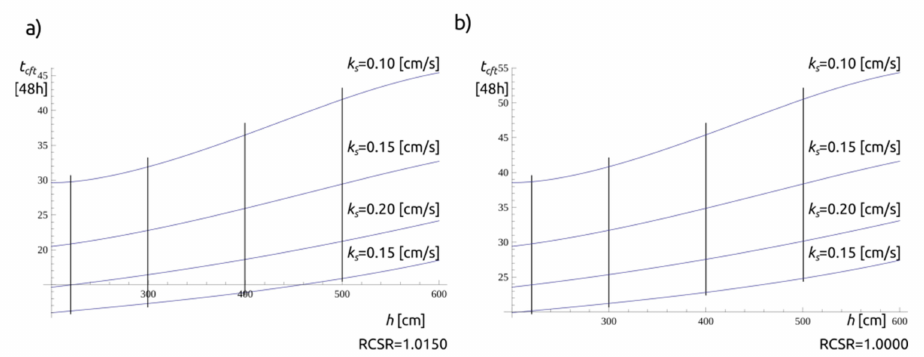
Figure 14. Values of t cft at selected RCSR values and profiles ( a ) for RCSR = 1.0150 and ( b ) RCSR =